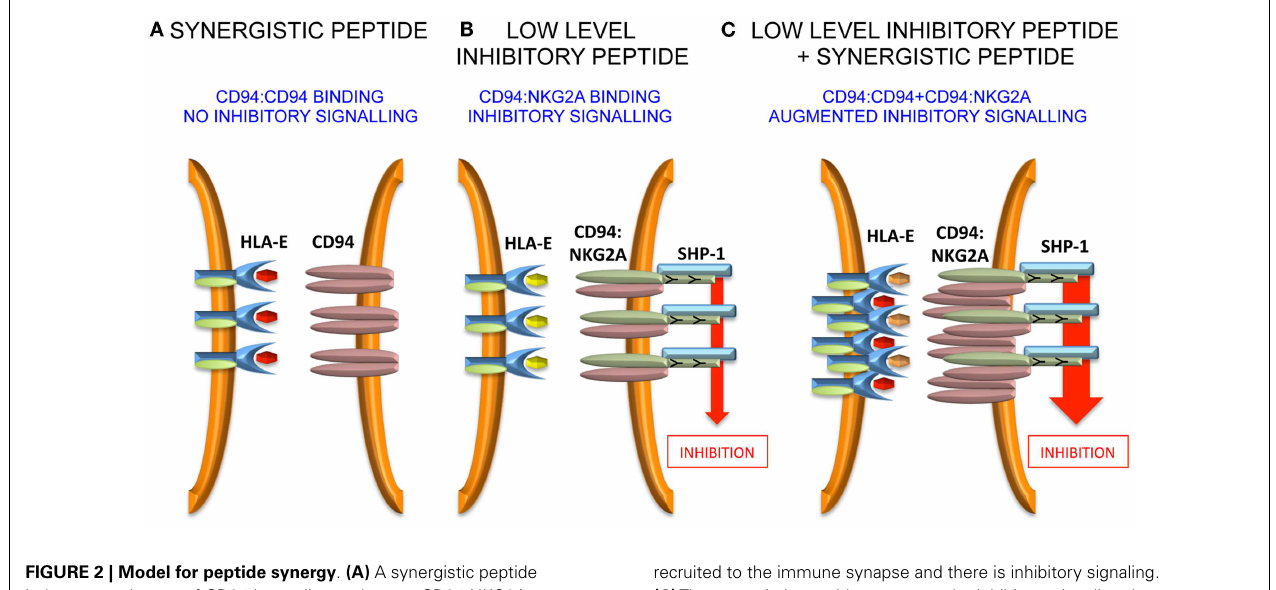
FIGURE 2 | Model for peptide synergy . (A) A synergistic peptide induces recruitment of CD94 homodimers, but not CD94:NKG2A to the immune synapse.Therefore, there is no inhibitory signal generated. (B) At low levels of inhibitory peptide CD94:NKG2A is